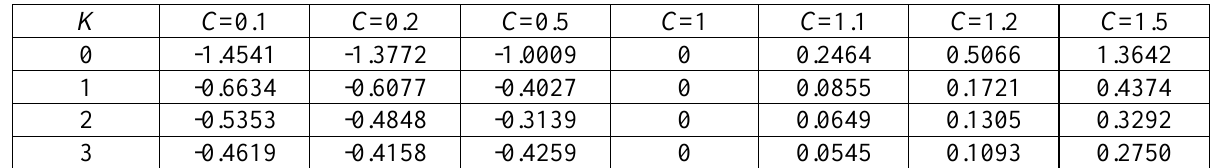
Table 1. Variation of the wall shear stress )0( f